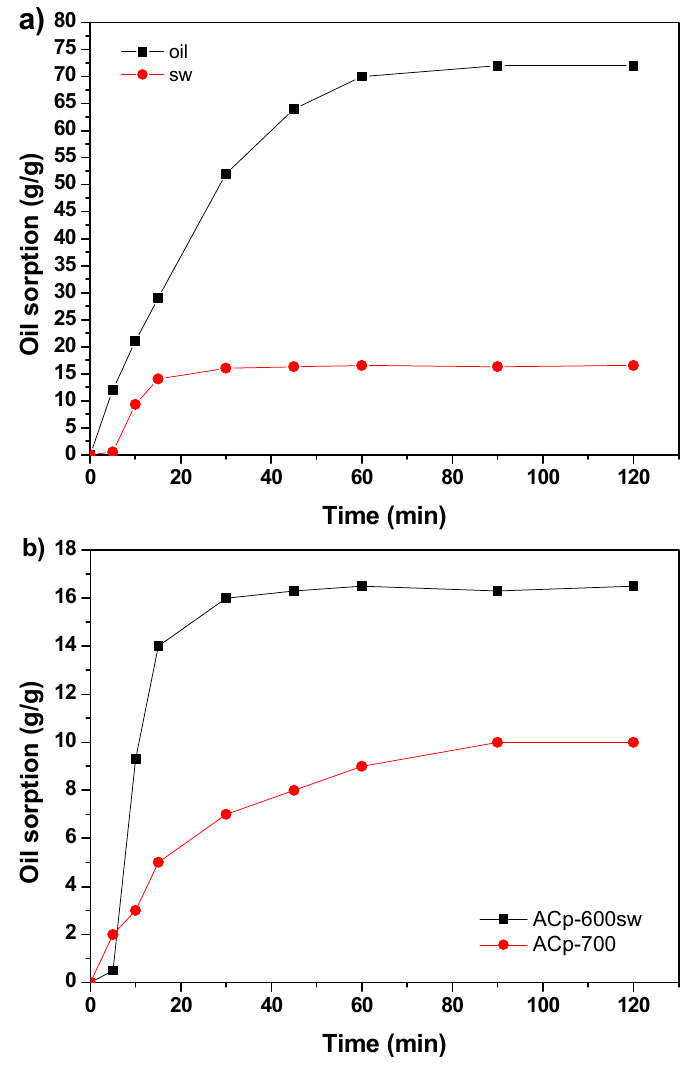
Figure 5. Comparative oil sorption capacity at 20 °C; ( a ) ACp-600 in oil and ACp-600 in oil/seawater system (ACp-600sw), ( b ) ACp-600sw and ACp-700 in oil system.